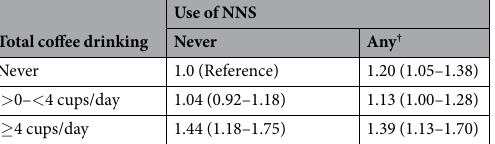
Table 5. Interactions of coffee drinking and sweeteners use in relation to major depression risk * . NNS = non- nutritive sweetener. * ORs and 95% CIs were computed with adjustment for age, sex, ethnicity, education, province of residence, smoking status, alcohol drinking, self-reported cardiovascular disease and diabetes, healthy eating index (in tertiles), total physical activity (in MET-min/week tertiles), and BMI. † Non-nutritive sweetener use in coffee or tea or diet drinks.